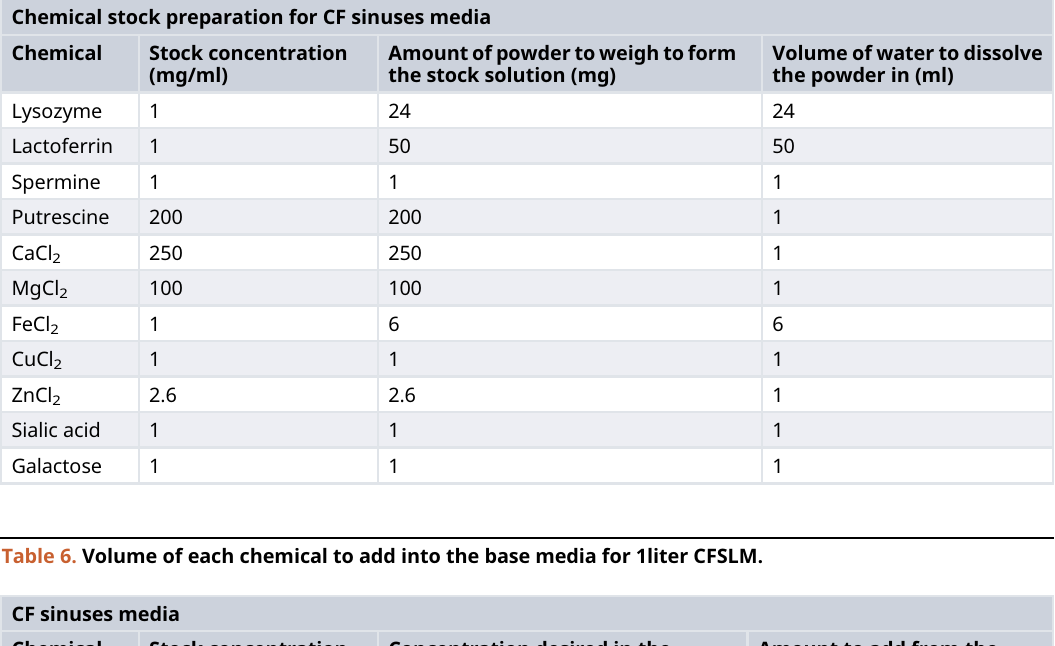
Table 5. Preparation of chemical stocks for CF sinuses media.